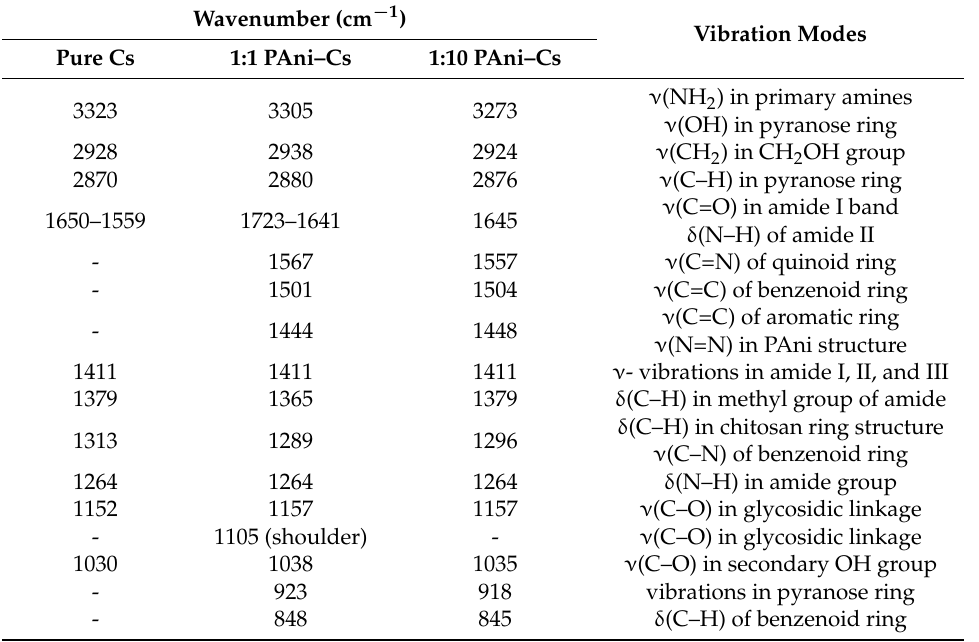
Figure 4. Synchrotron radiation-based Fourier-transform infrared (SR-FTIR) spectra of Pure Cs, 1:10 PAni–Cs, and 1:1 PAni-Cs composites. a.u.: Arbitrary units. Table 3. Characteristic absorption bands in the synchrotron radiation-based Fourier-transform infrared (SR-FTIR) spectra of pure Cs, 1:10 PAni–Cs, and 1:1 PAni–Cs composites.